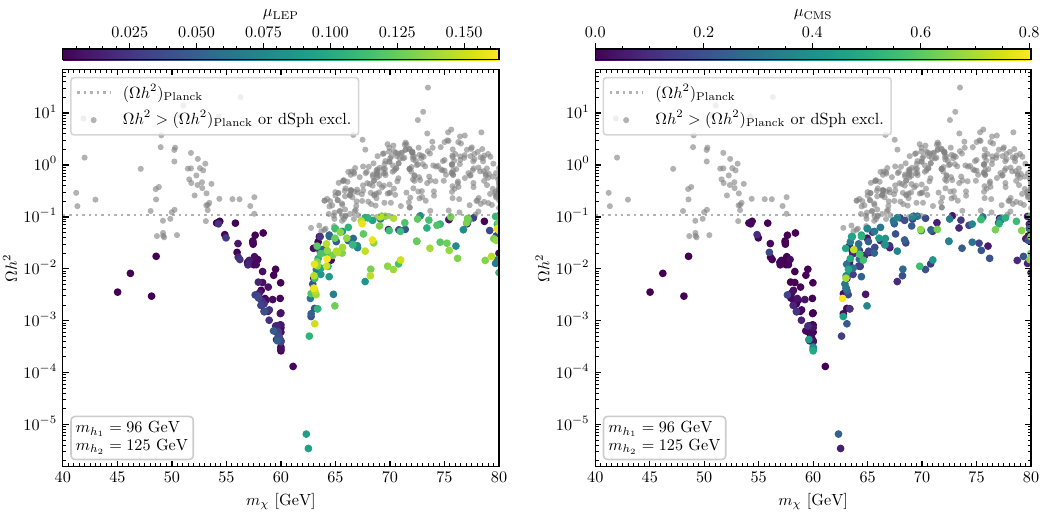
Figure 7 . Ω h 2 in dependence of m χ , with the colour coding indicating the values of µ LEP (left) and µ CMS (right). Grey points are excluded by Ω h 2 > (Ω h 2 ) Planck or Fermi dSph measurements.